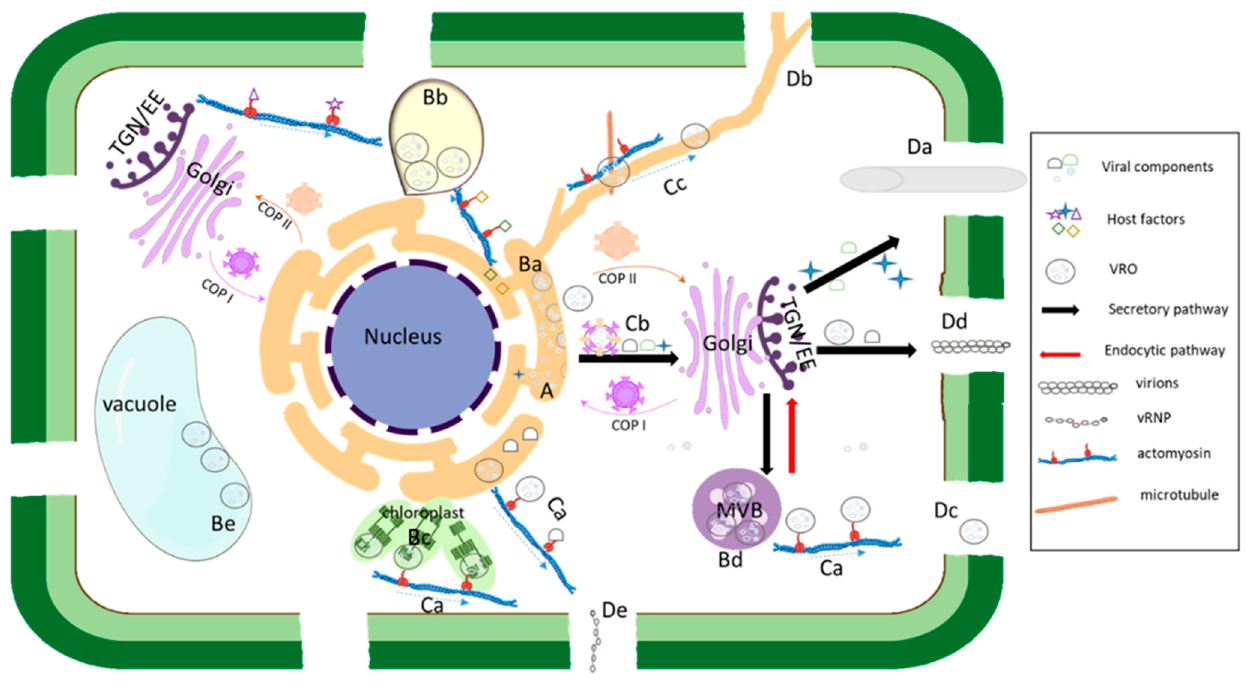
Figure 2. Schematic representation of the involvement of endomembrane system and cytoskeleton in viral replication and movement. Early in the infection process, translation of viral RNAs occurs at the rough ER (A). The viral membrane-targeting protein(s) target specific organelles such as the ER (Ba), peroxisomes (Bb), chloroplasts (Bc), multivesicular bodies (MVBs) (Bd) and vacuole (Be) and remodel organellar membranes to initiate the formation of viral replication organelles (VROs), and various virus-specific host proteins (host factors) are recruited to VROs. Dependent on virus, different cellular endomembrane-cytoskeleton network components, such as the ER, ER-Golgi, microtubules, actin filaments and endosomes, are hijacked to play roles in VRO biogenesis. VROs, viral movement protein(s) (MPs) and MP-associated viral movement complexes traffic to the plasmodesmata (PD) via the cytoskeleton machinery (mainly the actomyson mobility system) (Ca), secretory pathway (Cb), or the ER membrane (Cc). To pass through the PD, some viral MPs may form tubules within the PD to displace the desmotubule (Da) and others may increase the size exclusion limit (SEL) of PD (Db). Different viruses may pass through the PD via different MP-associated complexes: VRO (Dc), virion (Dd), or the viral ribonucleoprotein (vRNP) complex (De). Despite the signi fi cant advances in the role of the endomembrane-cytoskeleton net- work in VROs biogenesis, many intriguing questions remain to be answered. For example,